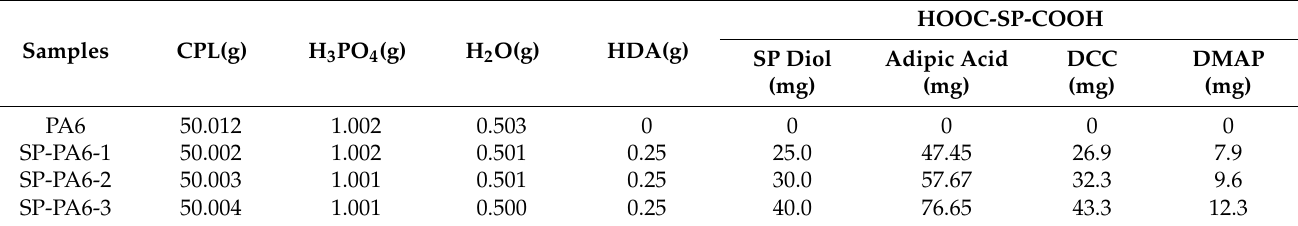
Table 1. Synthesis formulation of photochromic